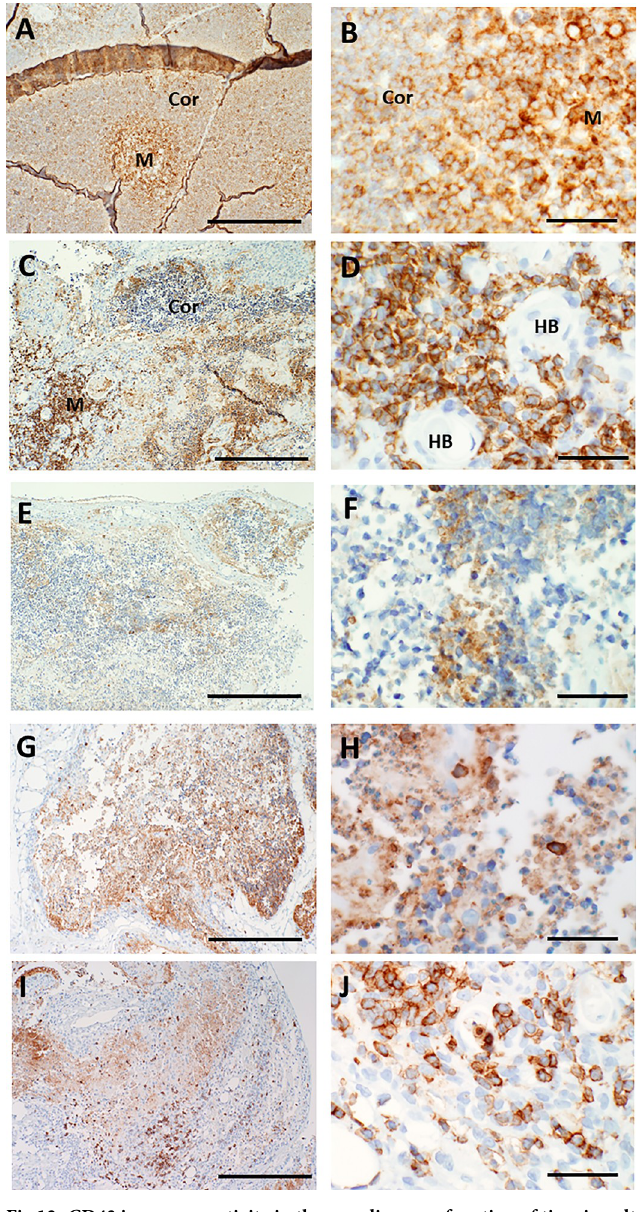
Fig 12. CD43 immunoreactivity in thymus slices as a function of time in culture. A, B. On day 0, immature thymocytes in the cortex (Cor) react weakly and those in the medulla (M) react more strongly with antibody specific for CD43. The dark bands in A are sectioning artifacts (wrinkles and folds in the tissue). Higher magnification (B) shows the brown positive membrane reactivity with both cortical and medullary thymocytes. C, D. By day 7, reactivity with CD43 antibody is generally limited to the medullary thymocytes. Some positive cells exhibit the expected specific membrane staining, but there is also considerable reactivity with cellular debris in cortical areas. Loss of membrane immunostaining and intense reactivity primarily with residual thymocyte debris is seen on days 9 (E, F), 12 (G, H) and 21 (I, J), although some cells with intact membrane staining can be detected at these later time points. Bar represents 500 μ m in panels A, C, E, G, and I and 50 μ m in B, D, F, H, and